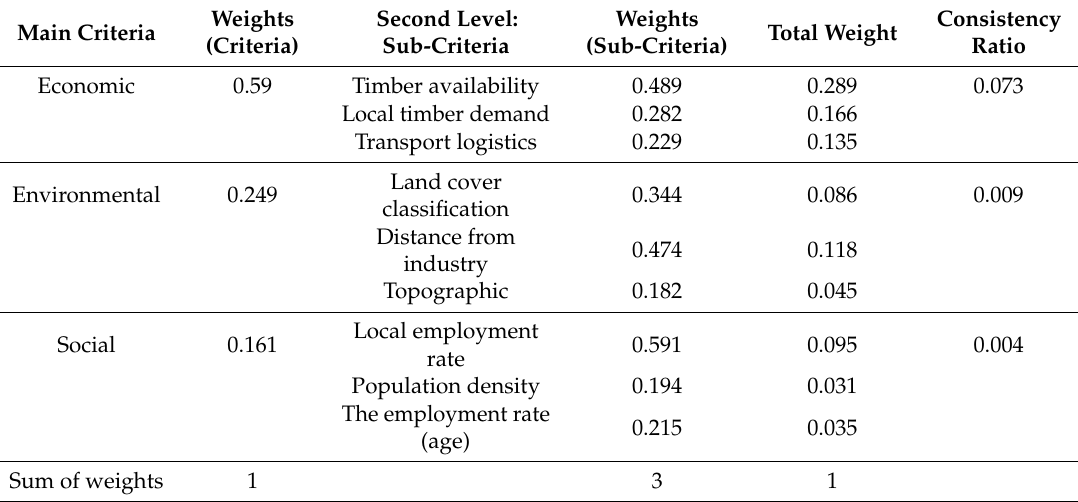
Table 6. Analytical hierarchy process (AHP) survey weights and preference